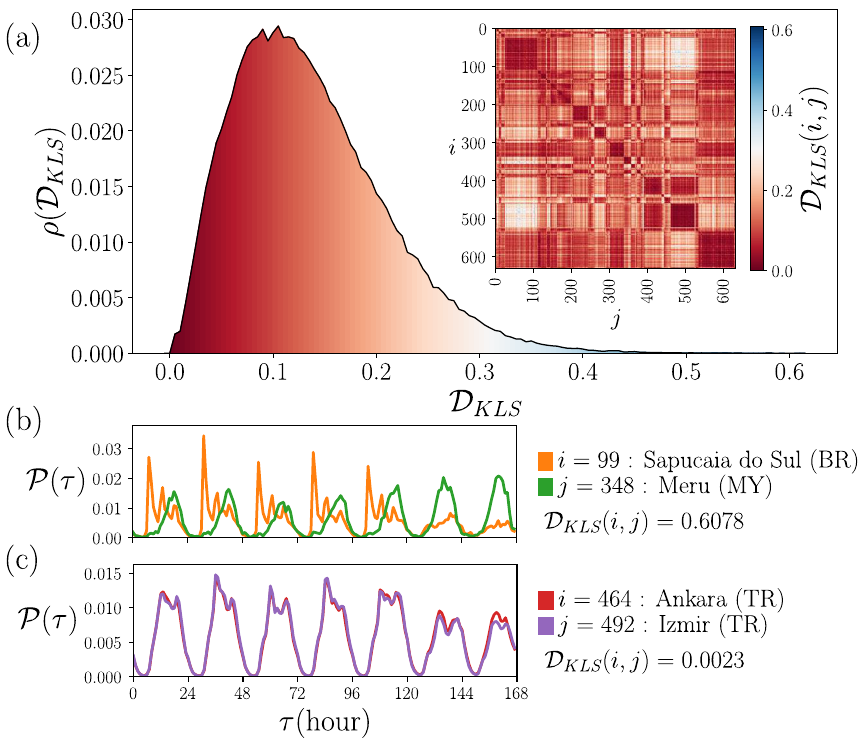
Figure 4. Comparison of temporal activity between cities. ( a ) Statistical analysis of the symmetric Kullback- Leibler distances D KLS from the comparison of check-ins temporal distribution by pairs. The values are obtained from Eq. (3) for all the city pairs i , j = 1, . . . , 632 . The probability density ρ( D KLS ) is obtained using bin counts in intervals with (cid:31) D KLS = 0.005 . The matrix with all the elements D KLS ( i , j ) is presented as an inset. ( b ) The two most different probability densities of the set are of the cities Sapucaia do Sul in Brazil and Meru in Malaysia, with D KLS = 0.6078 ; the maximum value found. ( c ) The two most similar cities of our sample, are Ankara and Izmir both in Turkey, with D KLS = 0.0023 , the minimum non-null value. All figures were created using python 3.8 and the matplotlib (3.5.0) package (https:// matpl otlib.